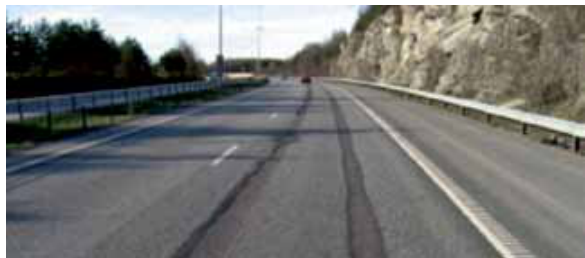
Fig. 2. Studded tire wear in Norway (Haugødegård 2008)